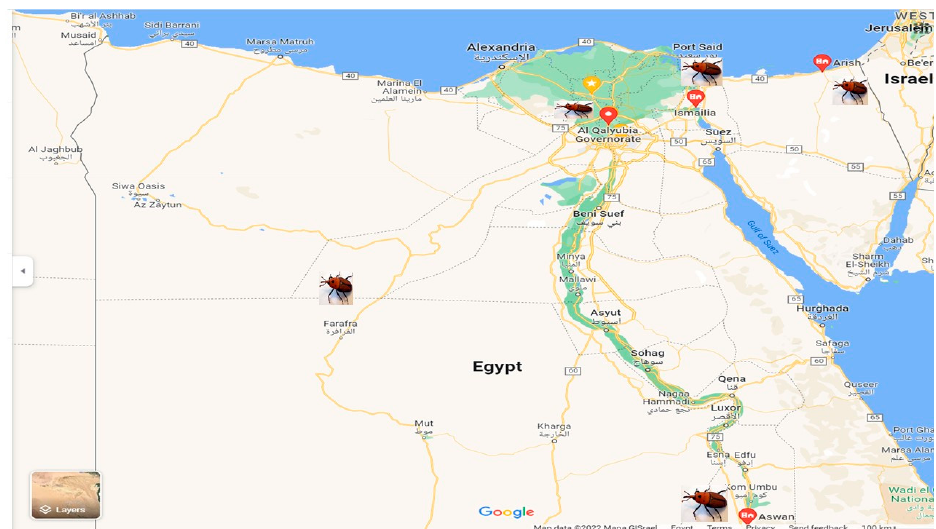
Figure 1. Localities from which R. ferrugineus was collected.